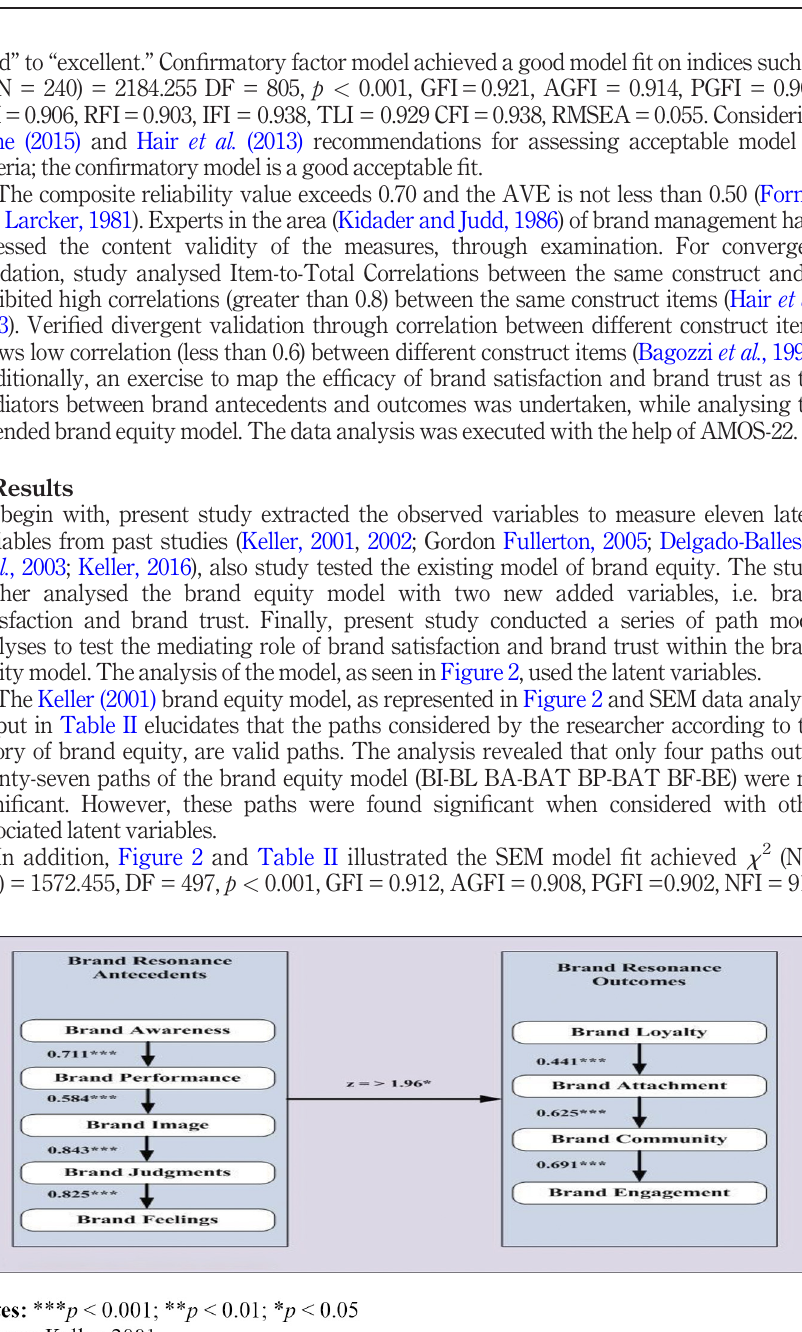
Figure 2. Existing SEM model of brand